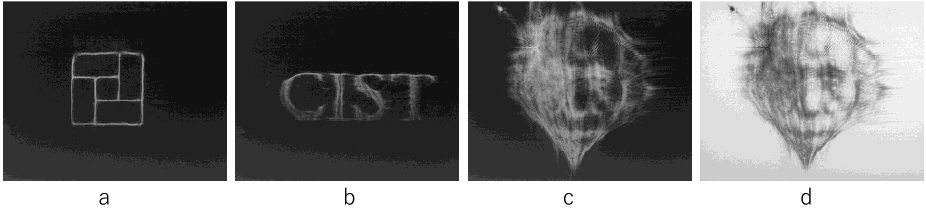
Figure 9. Experimentally obtained diffraction patterns of phase-only holographic masks. From ( a – c ), they are the diffraction patterns of the rectangular mask, the “CIST” mask and the Einstein image mask, respectively, and ( d ) is the negative of ( c ).